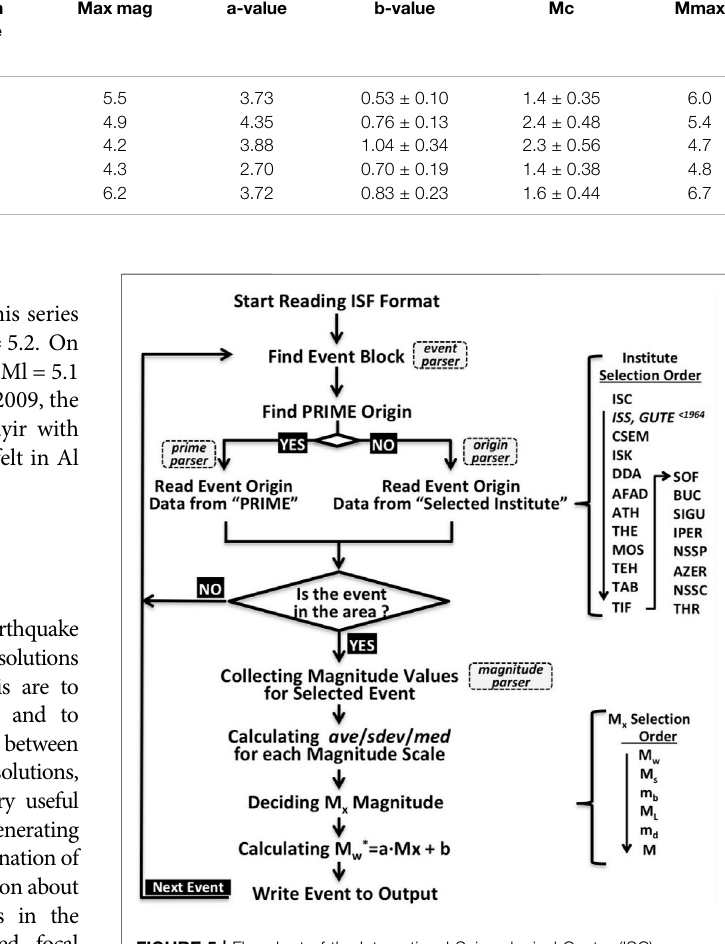
FIGURE 5 | Flowchart of the International Seismological Centre (ISC) database processing. Ave, average (mean); Med, median; Sdev, standard deviation. Mw is equivalent moment magnitude. See Appendix A for the institute